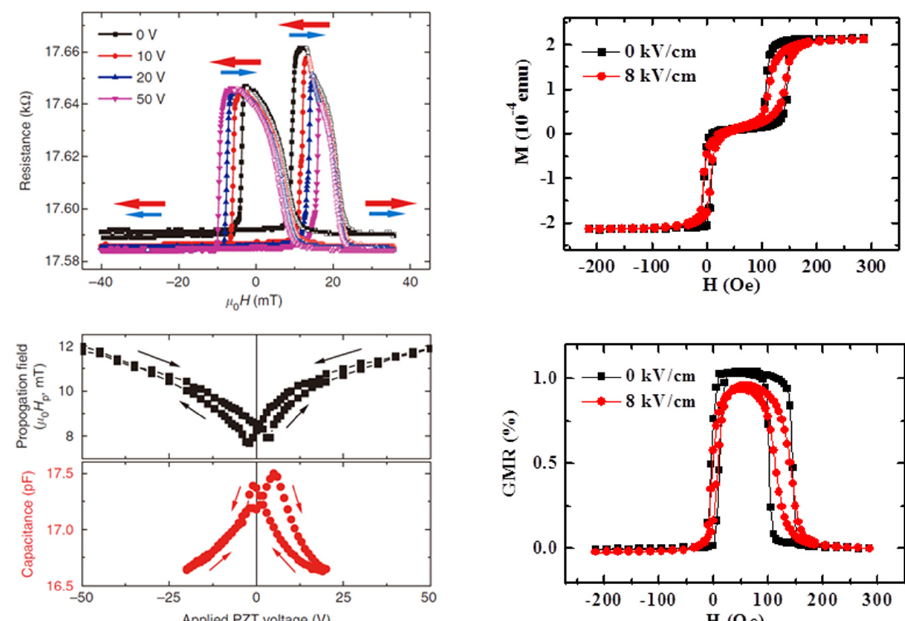
Figure 8. Strain-driven electric-field control of GMR. ( a ) Configuration of electric-field control of GMR in Co/Cu/CFB spin valve adjacent to the PZT layer. The reversible effect was shown as the voltage dependence of magnetic propagation field and capacitance in the bottom panel. The blue and red arrow in the middle panel denote the magnetization orientations of the CFB and Co layers, respectively. ( b ) Configuration of electric-field control of GMR in CFB/Cu/CFB spin valve on the (011)-cut PMN–PT substrate. The corresponding electric-field control of magnetization and GMR with applied magnetic field along the [100] direction. Reproduced with permission from reference